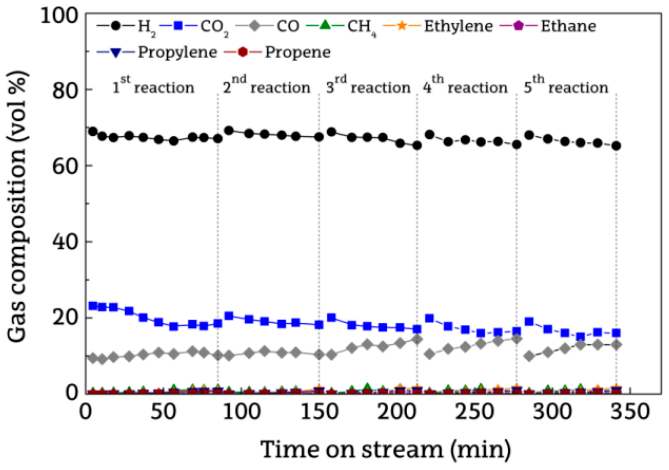
Figure 3. Evolution of the gaseous product composition with time on stream for five consecutive reaction-regeneration cycles.